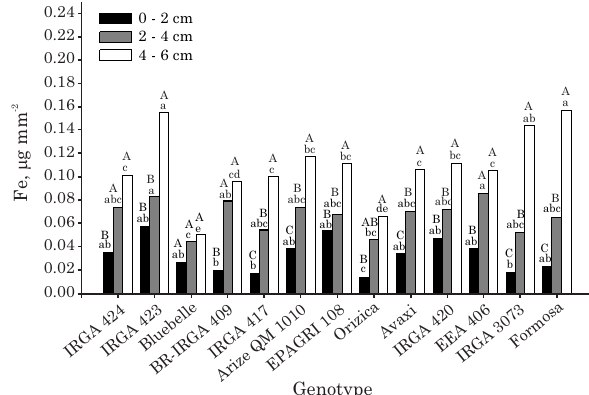
Figure 4. Iron distribution in three segments of adventitious roots of rice genotypes obtained under hypoxia after exposure to a solution of an Albaqualf soil with pH = 6.0 and 80 mg L -1 of Fe. Lowercase letters compare genotypes for each segment and uppercase letters compare segments within each genotype by the LSD test (p<0.05).